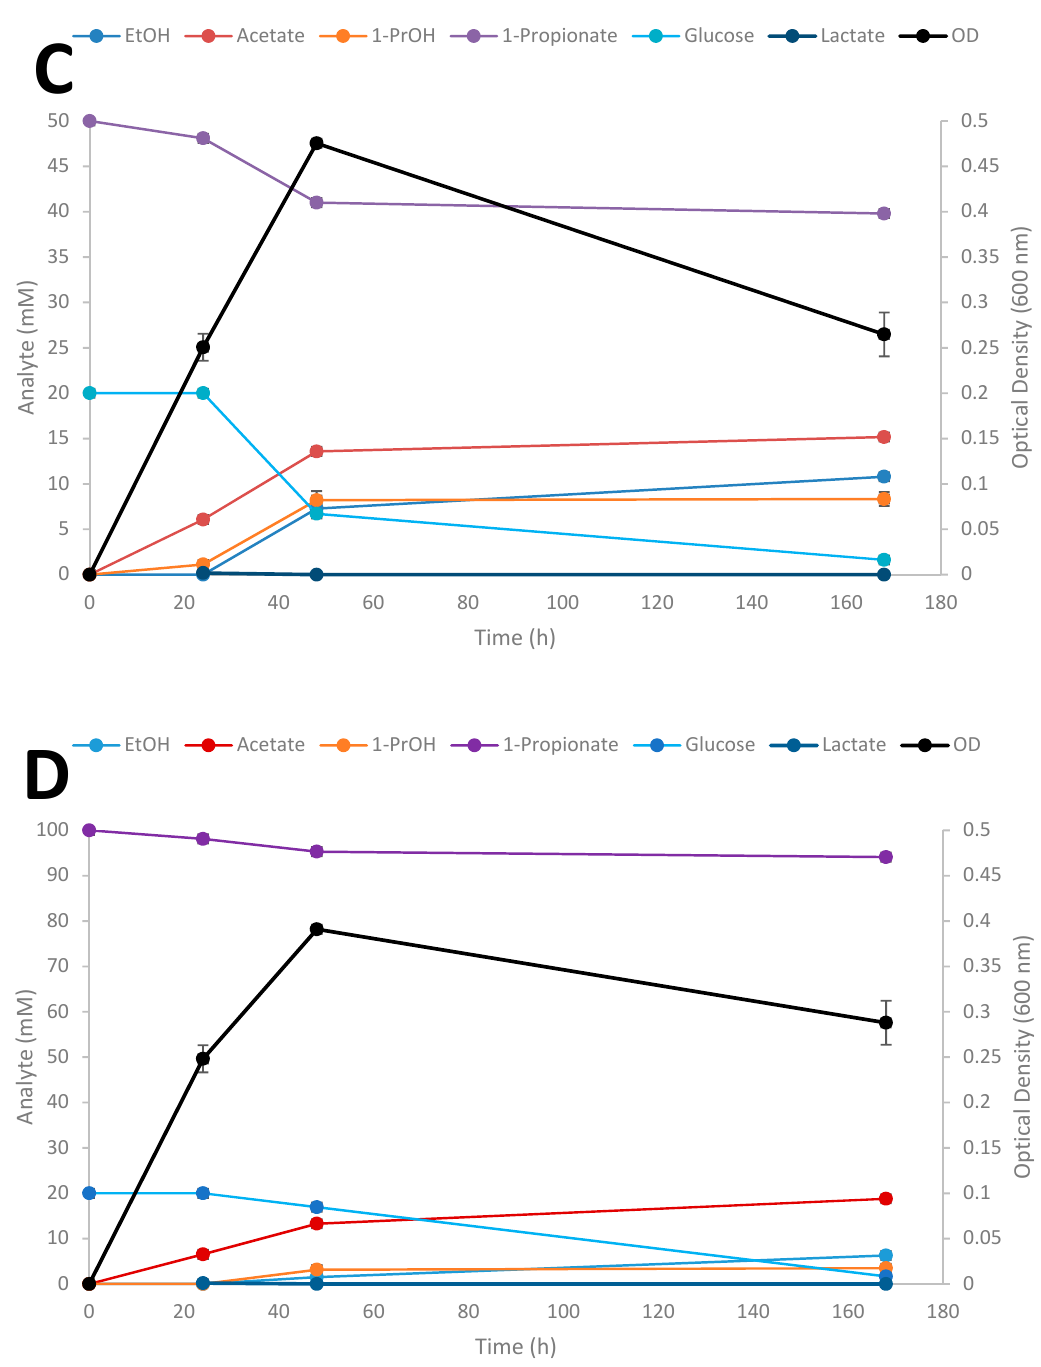
Figure 6. Fermentation of 20 mM glucose ( A ), 20 mM glucose + 20 mM propionate ( B ), 20 mM glucose + 50 mM propionate ( C ), 20 mM glucose + 100 mM ( D ) by Thermoanaerobacter strain AK152. Values represent the average of triplicates ± standard deviation.